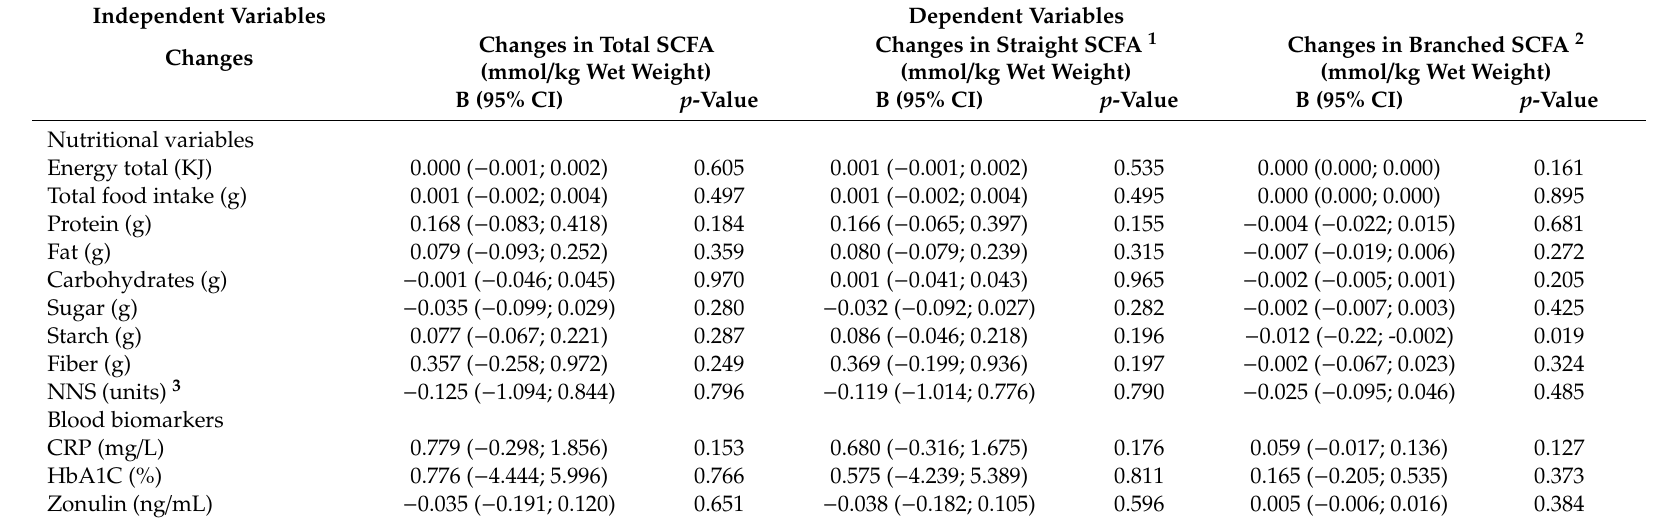
Table 4. Associations between changes in the SCFA levels and changes in nutrients, blood biomarkers and faecal microbiota composition markers (linear regression adjusted for age and